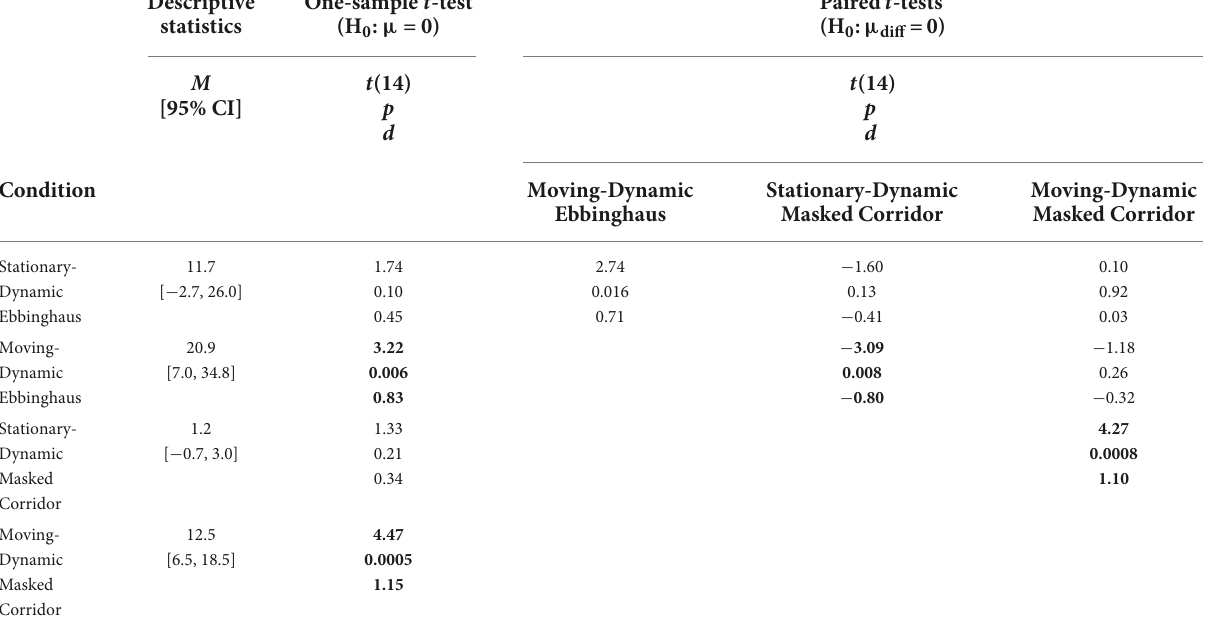
TABLE 2 One-sample and pairwise paired t -tests for all conditions with surrounding context of Experiment 2. Descriptive statistics